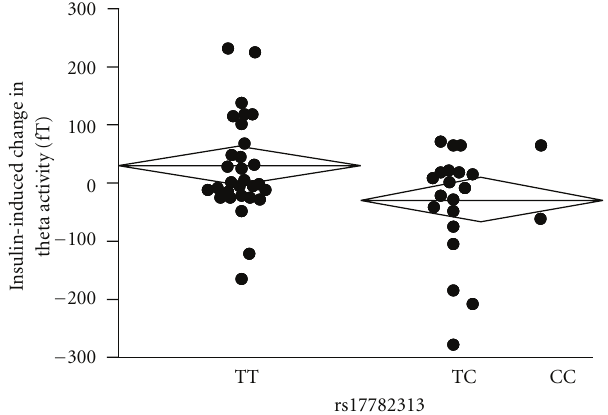
Figure 1: Insulin e ff ect on theta activity in the genotype groups : in subjects carrying the rare allele of rs17782313 in the homozygous (TC) or the heterozygous form (CC), the e ff ect of insulin on theta activity was significantly reduced as compared to carriers of the wild-type allele (TT) ( P = . 023). The diamonds show the means of each group (horizontal line) and the confidence intervals of the means (upper and lower point). The e ff ect of the genotype remained significant after adjusting for BMI ( P = . 038) and also after adjusting forBMI and peripheral insulinsensitivity ( P = .